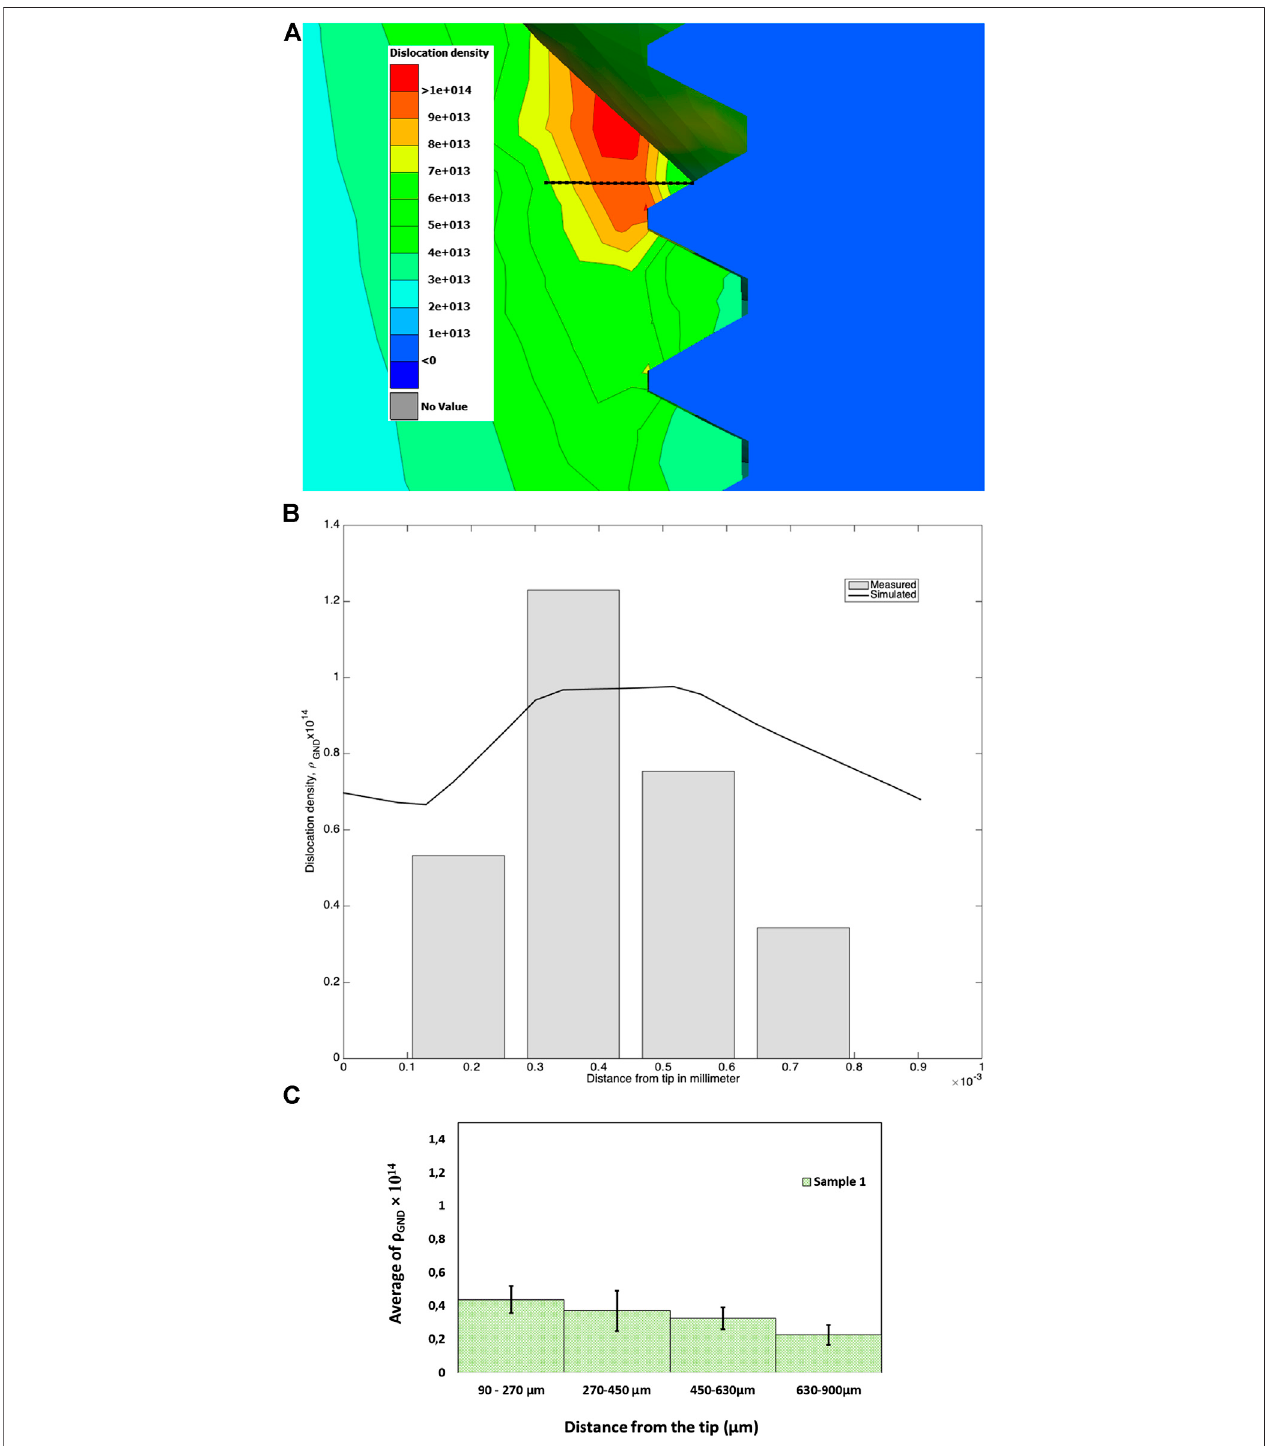
FIGURE6| Across-sectionoftheattached screwinanattempttoillustratethedislocation density(m/m 3 )inthetopthread.Thedislocationdensity isshownat the end of the assembly process. (A) Distribution of dislocations at the end also showing the center line along which the dislocation density was taken for comparison with measurements, (B) the simulated and measured dislocation density along the center line. The simulated average dislocation densities are given as function of the distance from the thread tip after the complete assembly process, (C) the initial distribution of dislocations used in the model and the measured distribution.